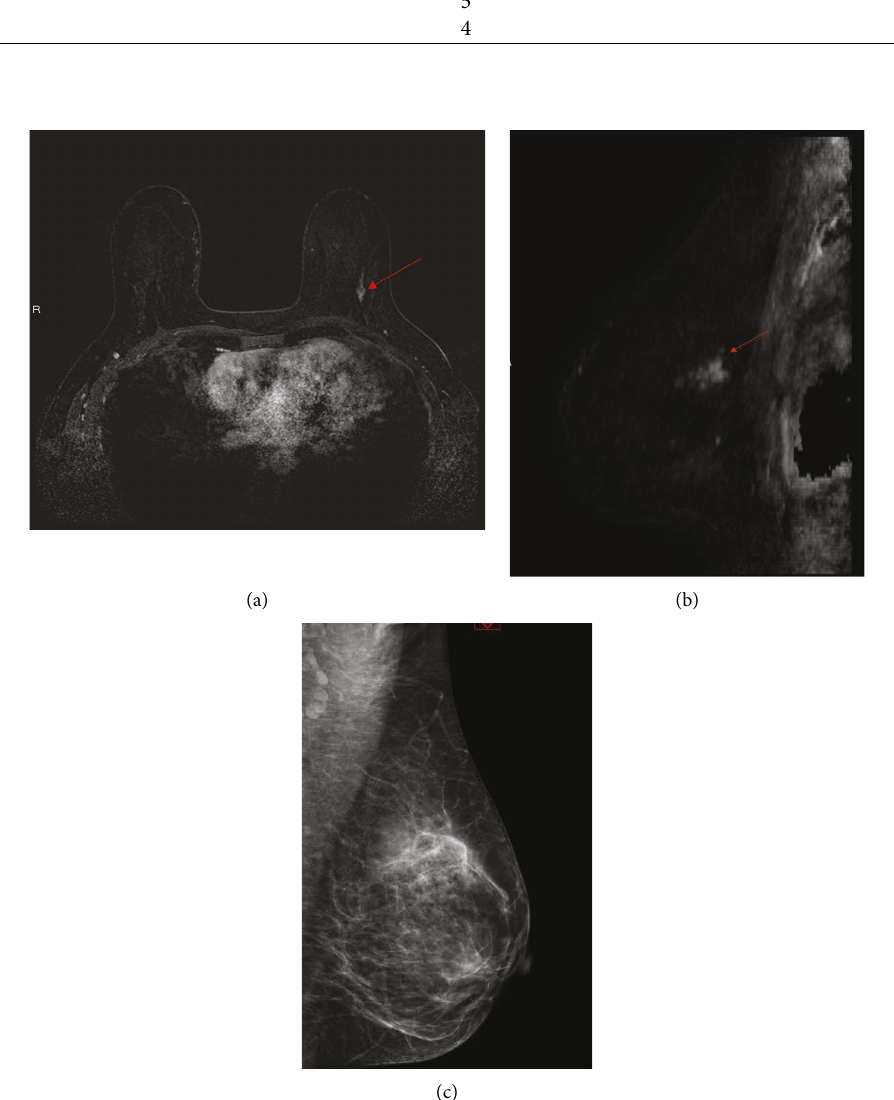
Figure 2: 40 year-old BRCA1 patient undergoing annual MRI. Axial (a) and Sagittal (b) reconstruction showing a segmental nonmass enhancement in the left breast (red arrow). Mediolateral (MLO) view of mammography of the same breast shows no corresponding